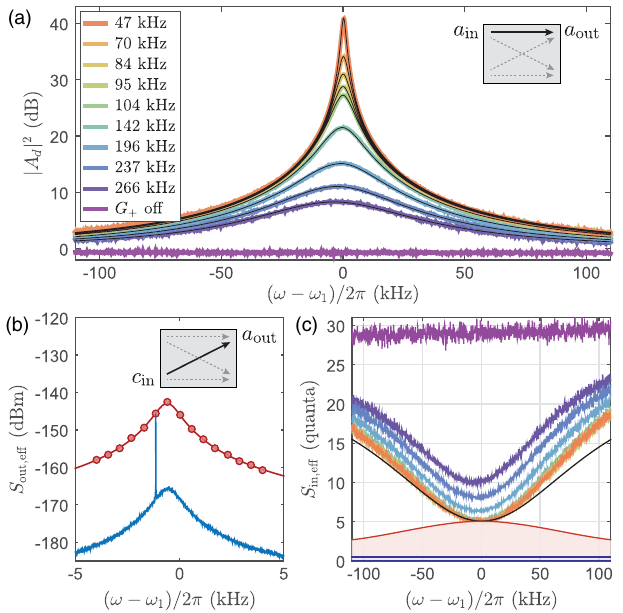
j 2 FIG. 2. Two-mode amplifier performance. (a) Direct gain j A d versus signal frequency for fixed G − and various values of G þ (colored lines, legend shows G = 2 π ) together with theory fits (black lines). Inset: Amplifier configuration; the signal is input to cavity 1. (b) Example output spectrum of cavity 1 (blue line), showing high-gain frequency conversion of a weak signal injected in cavity 2 (narrow peak). The peak height at different frequencies (circles) agrees with the fitted model (red line). Inset: Amplifier configuration. (c) Effective input-referred noise for the same G − , G þ as in (a) (colored lines). The theory model (black line) is plotted only for the highest gain. The blue shaded area shows the input noise of one-half quanta at each input, and the red shaded area shows the modeled added noise S add